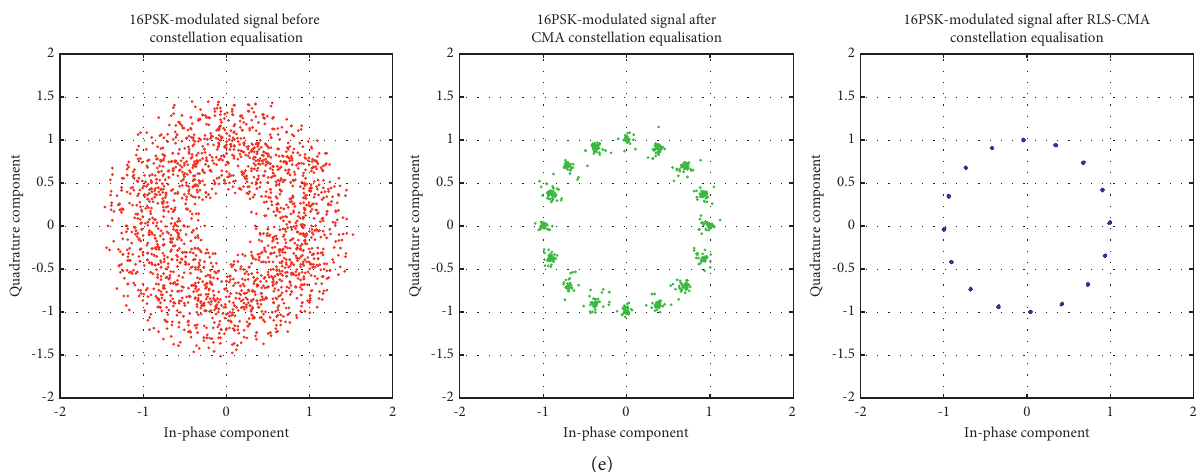
Figure 10: Constellations of the 16PSK-modulated signals obtained by different blind equalisation algorithms. (a) SNR � 15dB. (b) SNR � 25dB. (c) SNR � 35dB. (d) SNR � 45dB. (e) SNR � 55 dB.